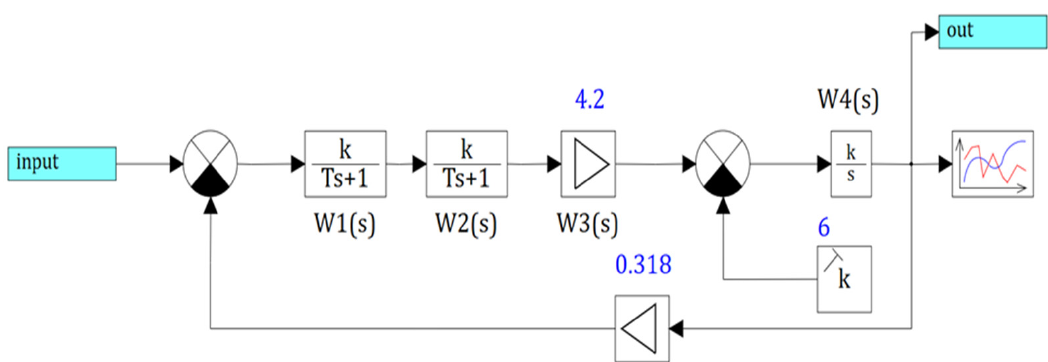
Figure 6. Schematic window with VI-IM submodel.